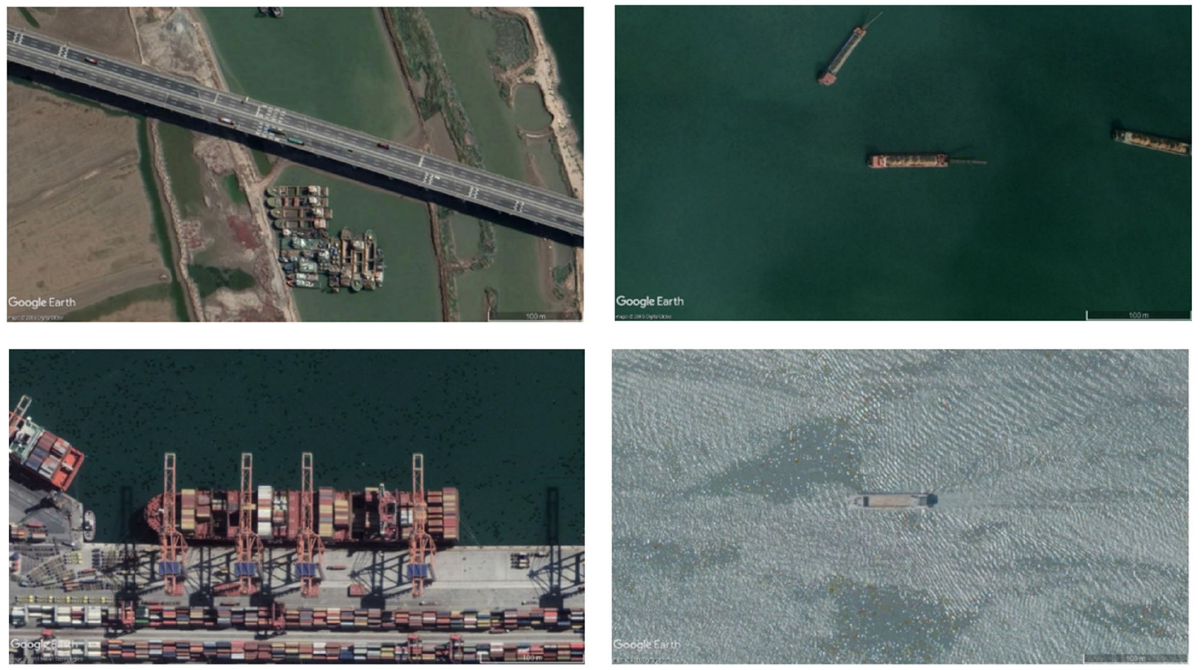
Figure A4. The example images from VHRShips with (left column) and without (right column) land background.